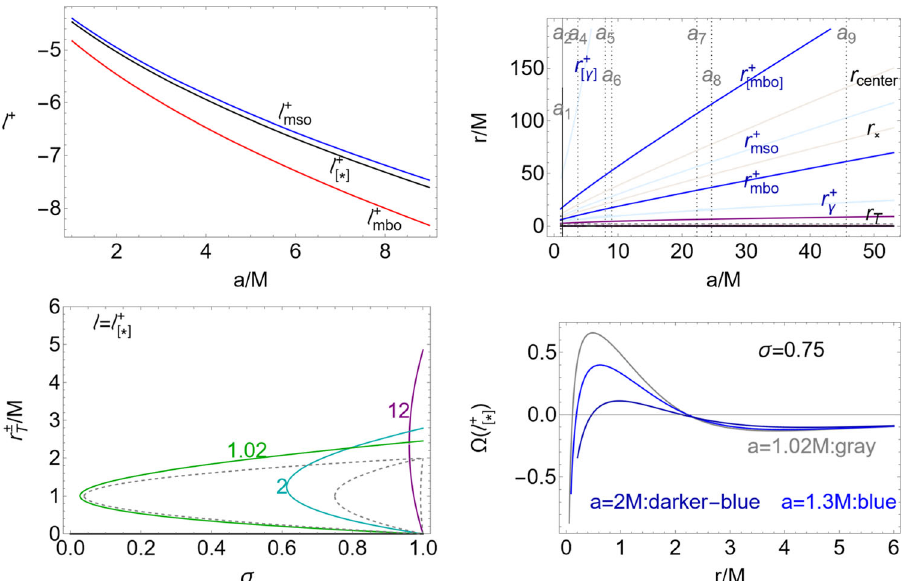
Fig. 6 Inversion points for counter-rotating tori with fluid specific angularmomentum (cid:6) = (cid:6) + < 0.Theanalysisfortoriwithfluidspecific angular momentum (cid:6) − is in Fig. 22. Spins { a 4 , a 5 , a 6 , a 7 , a 8 , a 9 } are defined in Table 2. There is (cid:6) + [∗] ≡ (cid:6) − ( r + [∗] ) , and r + [∗] ≡ r + mso − ( r + mso − )/ 2. Upper left panel: fluid angular momentum (cid:6) + r + mbo (on the marginally stable and marginally bounded orbit respectively) as functions of the NS spin-mass ratio. Upper right panel: geodesic struc- ture of the Kerr NS and the inversion radius r (cid:2) for the torus model with